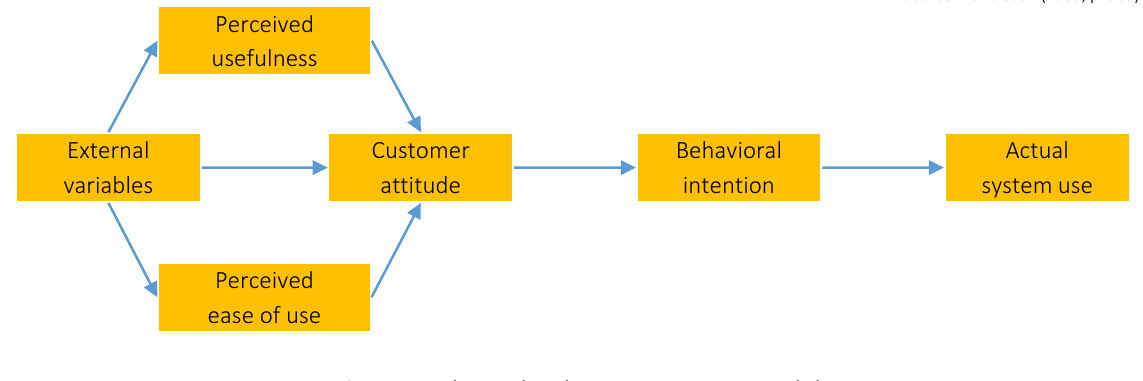
Figure 1. The technology acceptance